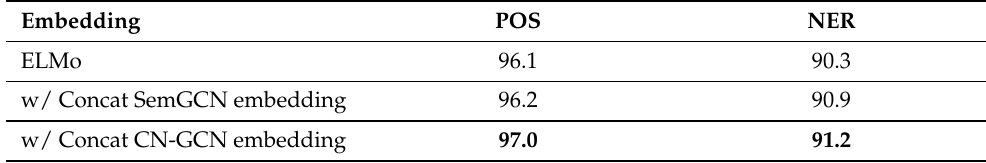
Table 5. Performance when initialization was performed with each word embedding in parts-of- speech (POS) and named entity recognition (NER) tasks. Bold indicates high performance.